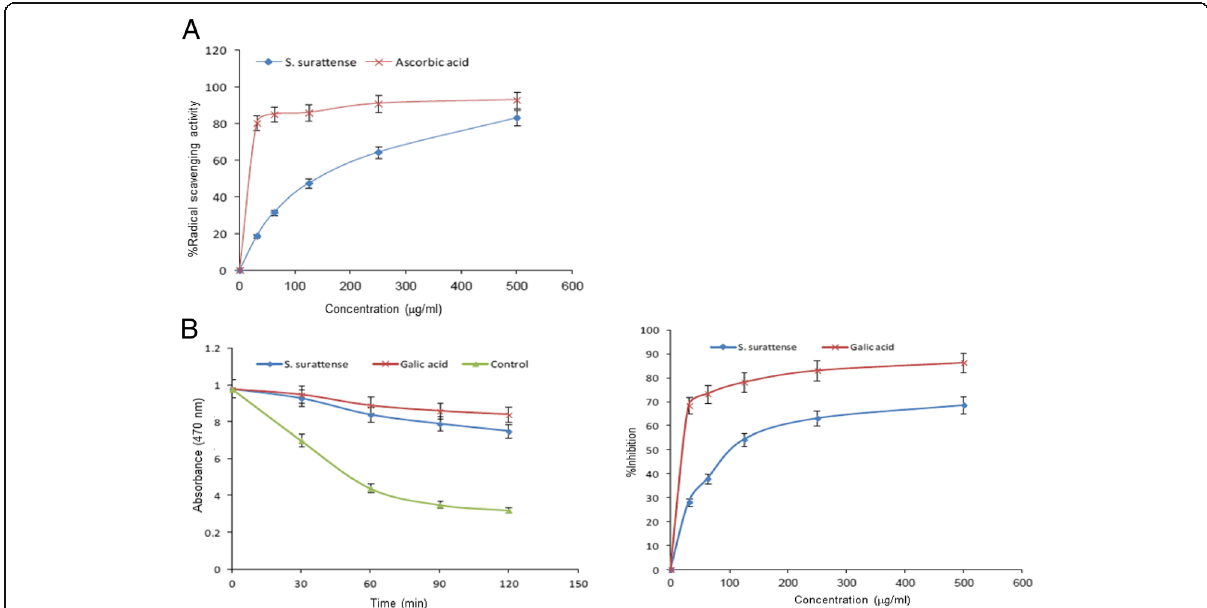
Fig. 3 In vitro antioxidant activity of S. surattense ethanol-extract (SSEE). a DPPH radical scavenging activity of different concentrations (31.25 – 500 μ g/mL) of total ethanol extract of S. surattense and standard antioxidant (Ascorbic acid). b β -carotene linoleic acid method showing β -carotene bleaching rate in presence of SSEE (500 μ g/mL), gallic acid, blank control (left panel) and %inhibition of lipid peroxidation by different concentrations of SSEE (31.25 – 500 μ g/mL) and gallic acid (right